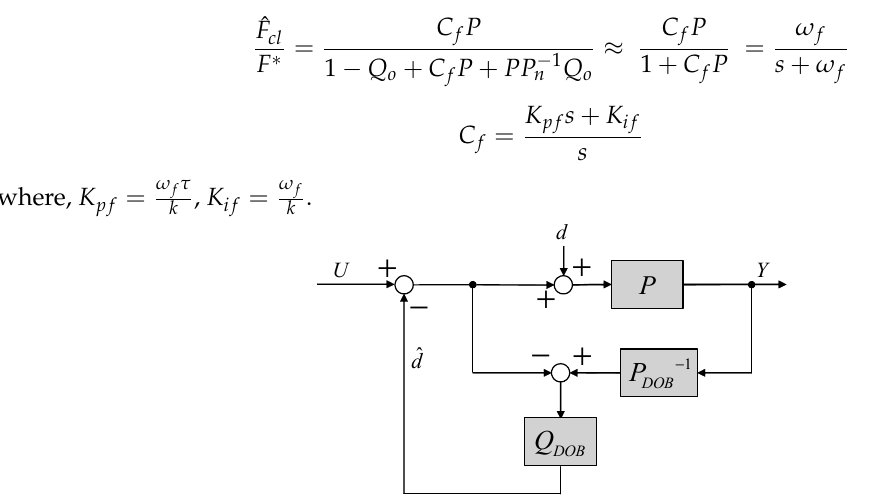
Figure 10. General framework of a disturbance observer.